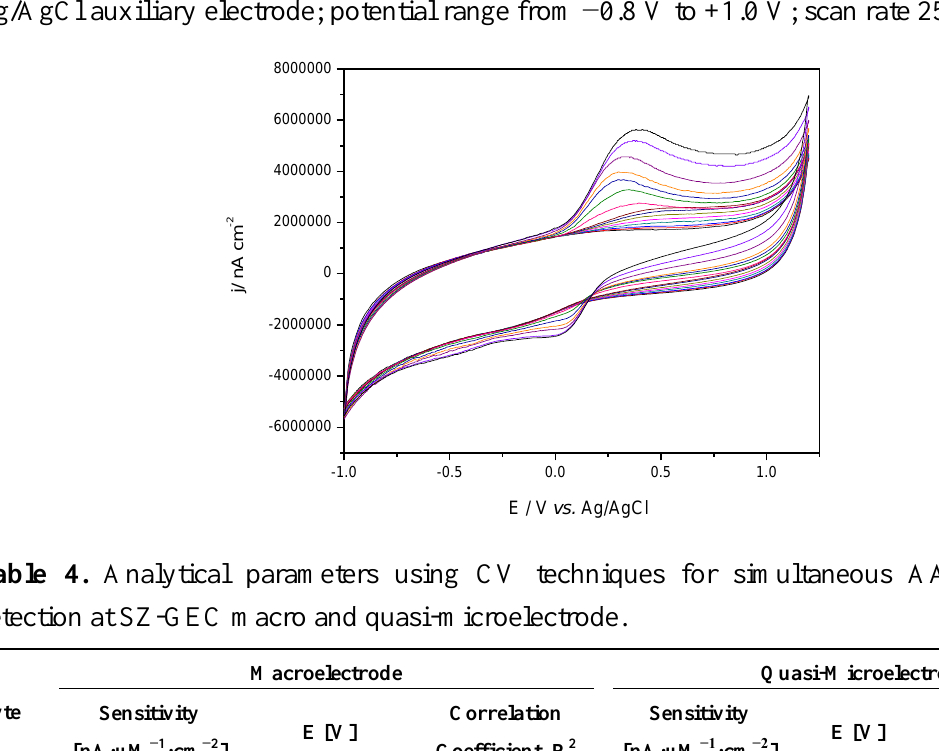
Figure 4. Cyclic voltammograms recorded at µ-SZ-GEC in 50 mM PBS supporting electrolyte with increasing concentrations of AA followed by increasing concentrations of